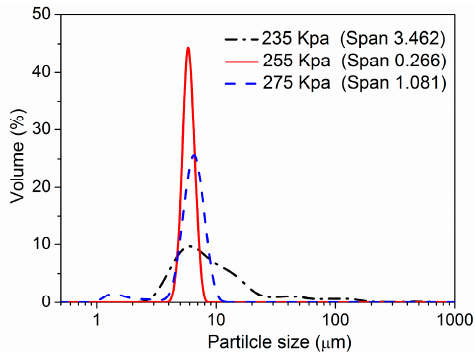
Figure 2. Size distributions of the semi-IPN3 microspheres prepared under different trans-membrane pressures.